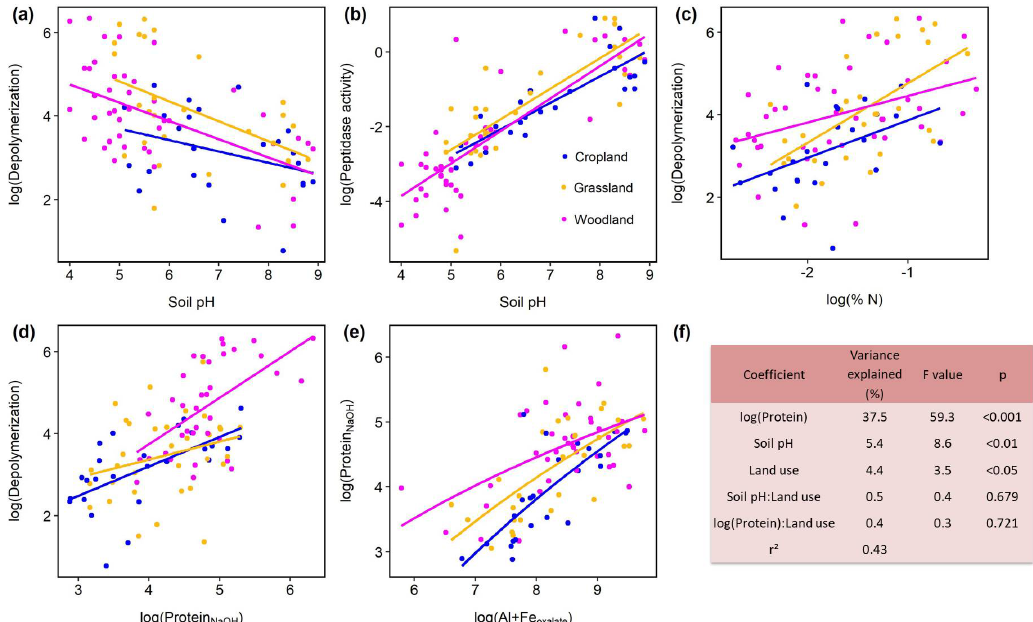
Figure 3. Effects of soil properties on gross protein depolymerization rates in mineral soils. Relationship of pH and (a) log(protein depoly- merization) and (b) log(leucine aminopeptidase activity). (c) Relationship of soil total N and protein depolymerization rate. (d) Relationship of NaOH-extractable protein and protein depolymerization rate. Color codes indicate land use type. (e) Relationship of oxalate-extractable Al and Fe and NaOH-extractable protein. (f) Analyses of variance of the most parsimonious linear regression model of log(gross protein depolymerization rate) explained by soil properties, land use and their interaction effects ( n = 95). Total model fit is given as adjusted r 2